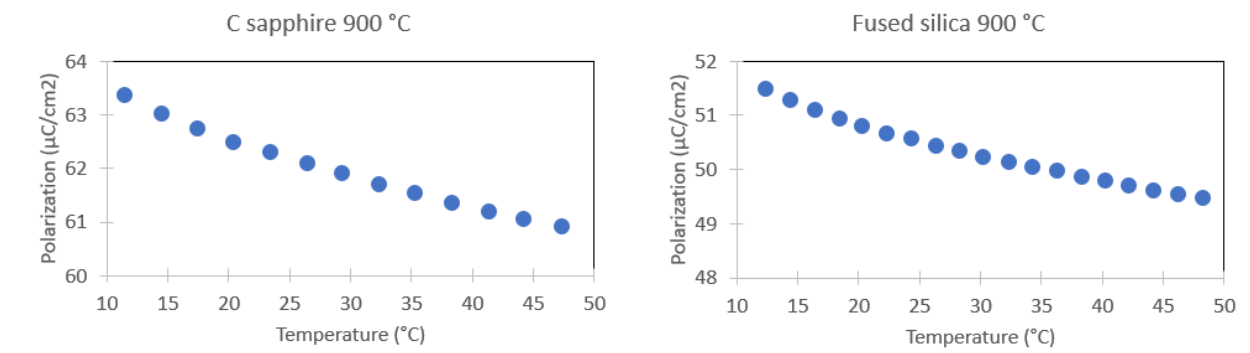
Figure 5. Maximum polarisation at 1330 kV/cm versus temperature for PST on c-sapphire and FS samples annealed at 900 °C. The measurements were performed on heating.